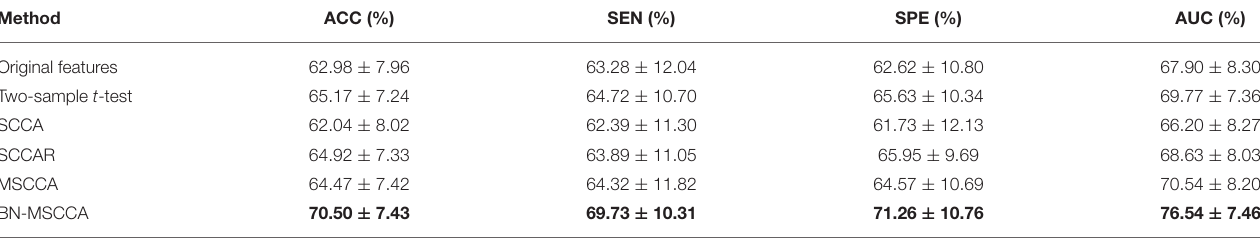
TABLE 3 | Comparison of classification performance on different feature selection methods (mean ± standard deviation).